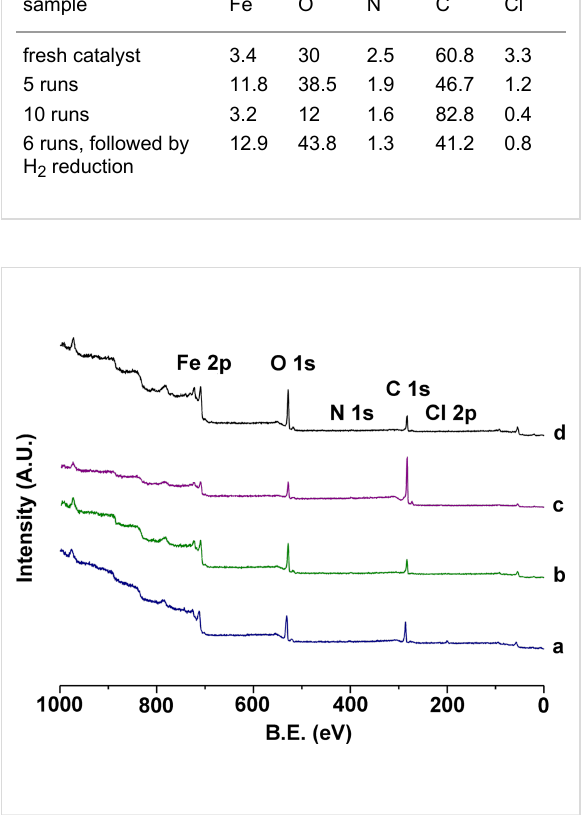
Table 1: Iron, oxygen, nitrogen, carbon and chloride content at the catalyst surface, as determined by XPS, as a function of catalytic runs. sample